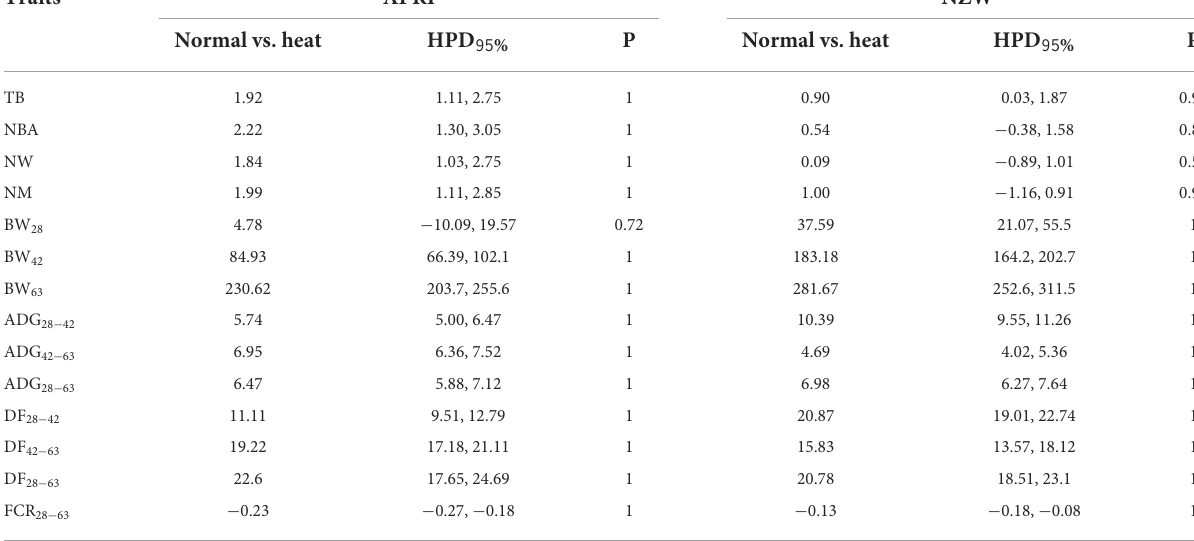
TABLE 3 Response of genotypes to environmental conditions for litter and growth traits. Traits APRI NZW Normal vs. heat HPD 95 % P Normal vs. heat HPD 95 %